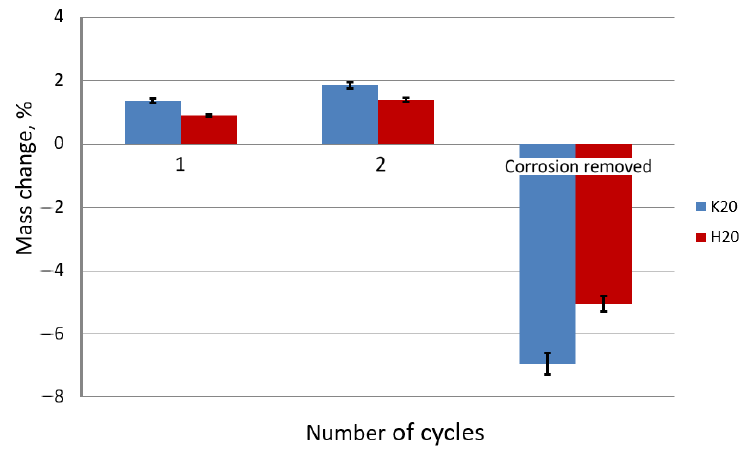
Figure 13. The percentage change in mass of the galvanized wire samples drawn at a speed of 20 m/s using the conventional K20 method and the hydrodynamic H20 method, made in a salt spray chamber, where the exposure took place in cycles.